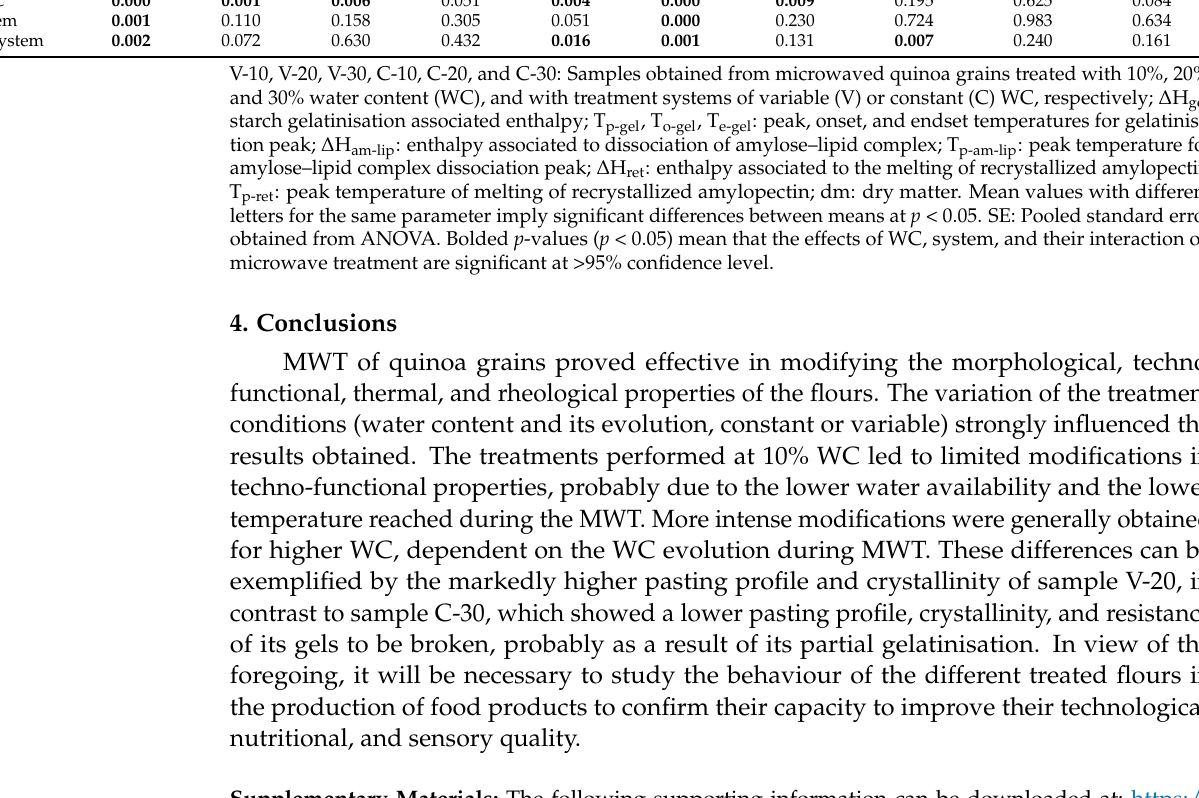
Analysis of variance and significance ( p